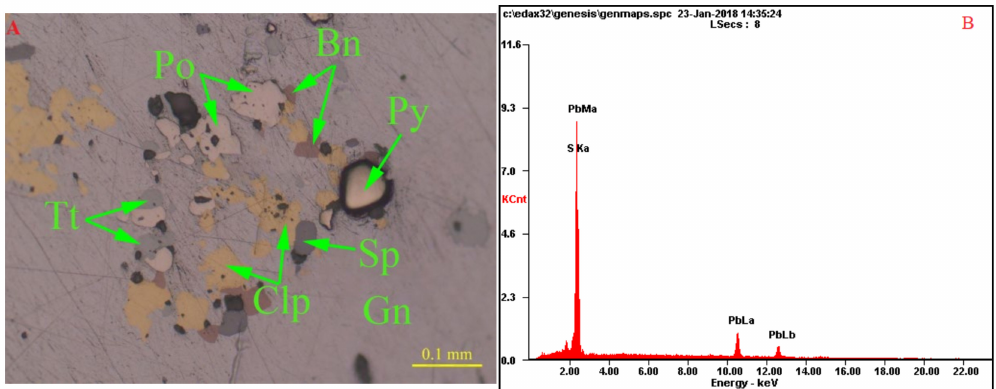
Figure 4. Images and EDS analysis of galena (Po = pyrrhotite, Bn = bornite, Py = pyrite, Clp = chalcopyrite, Tt = Tetrahedrite, Gn = galena, Sp = sphalerite); ( A ) represents the microscope image of the valuable mineral; ( B ) represents the EDS analysis of